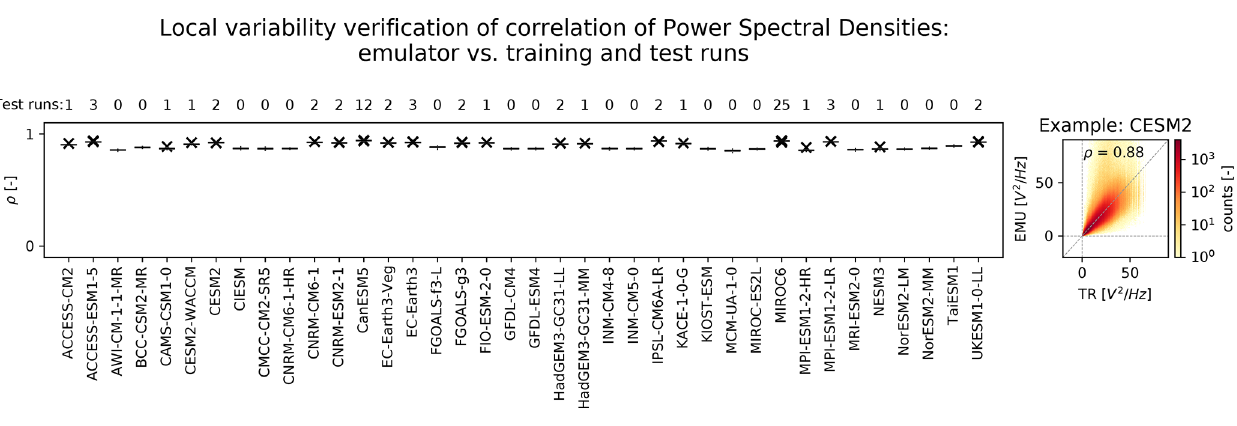
Figure 6. Verification of the time component of the local variability module by means of Pearson correlations between the power spectra of the 50 highest-frequency bands present within the training runs (i.e. considering all months together) and the power spectra at which the same 50 frequency bands appear within the respective emulations (boxplots, whiskers indicating 0.05 and 0.95 quantiles) calculated per grid point. Fifty emulations are evaluated per training run. Where test runs are available, their correlations with training runs are also given (black crosses). The example 2D histogram shows the power-spectra-to-frequency ratio for CESM2 training runs versus the corresponding power-spectra-to-frequency ratio within its